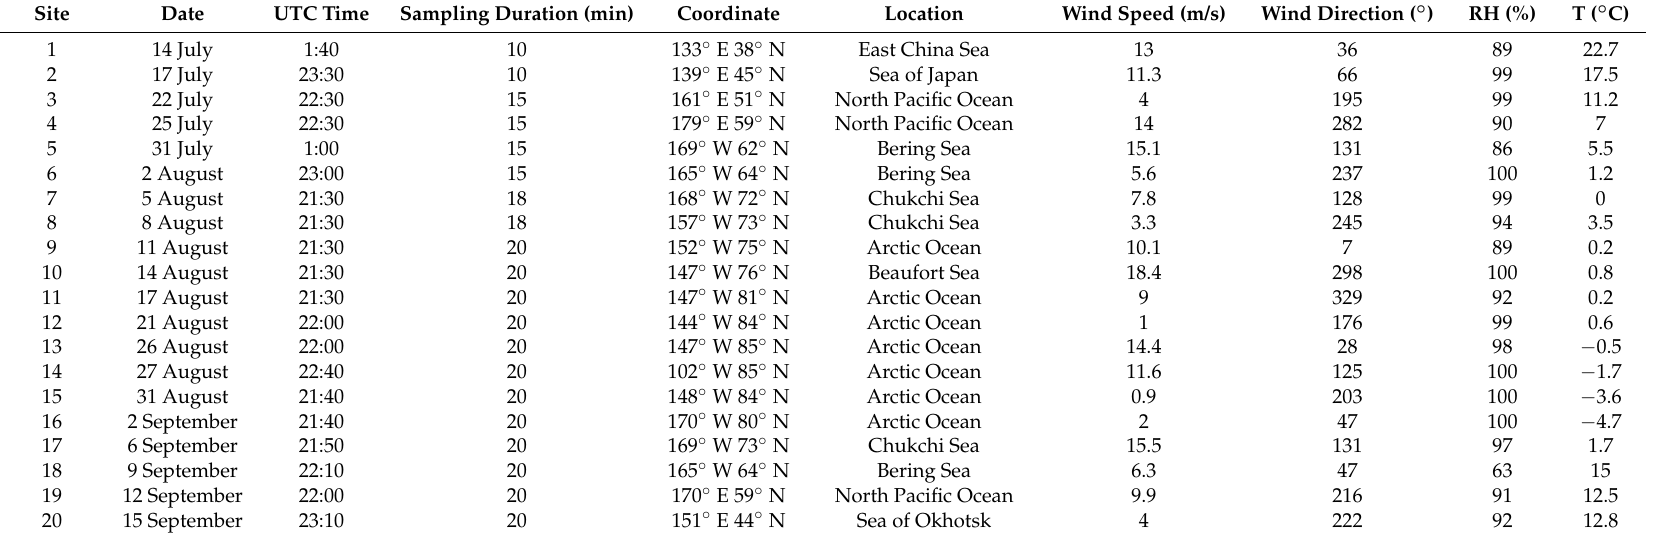
Table 1. Sampling location, date, and meteorological conditions during the third China Arctic Research Expedition,